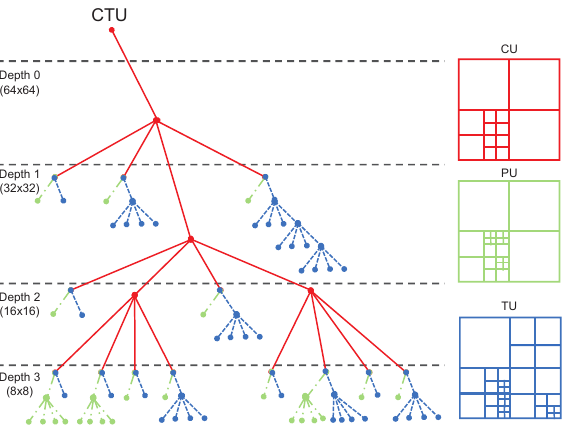
Figure 2. HEVC QT partition schema and the relationship between CU, PU and TU